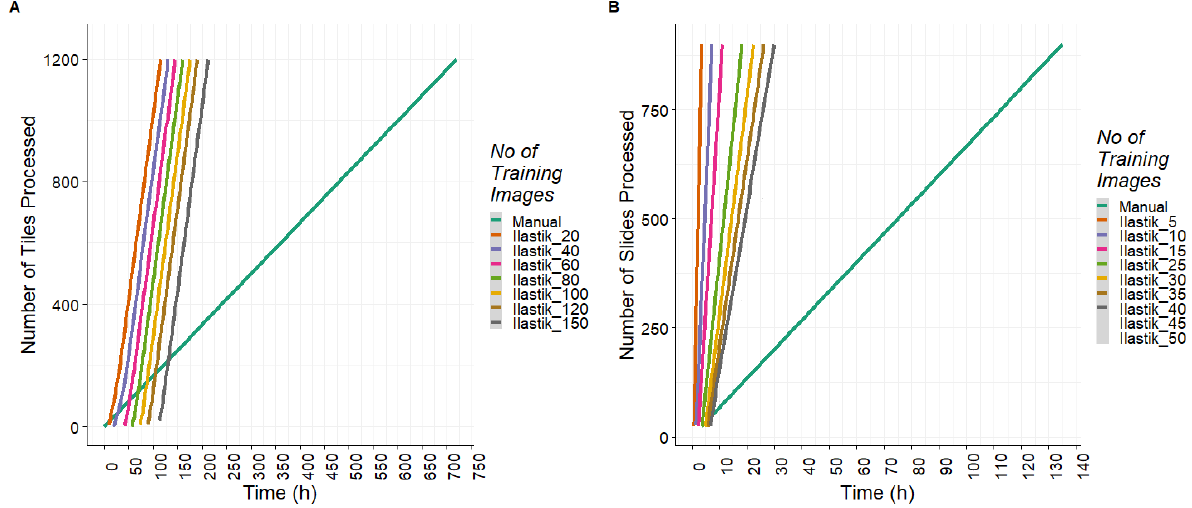
Figure 6. Time comparison between manual versus pipeline measurements. The time taken (hours) to process tiles ( A ) and slides ( B ) when training with different numbers of images (represented by different colors) and when using manual measurements versus the pipeline. Manual measurements are indicated by the light blue line on both graphs.